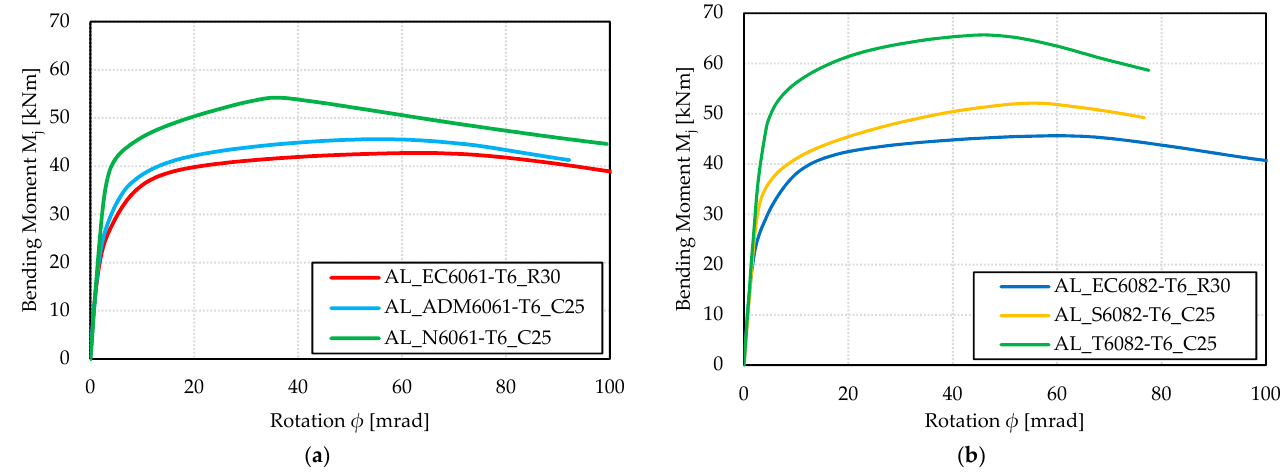
Figure 12. Moment–rotation curves for models with aluminium alloys: ( a ) EN AW-6061-T6; ( b ) EN AW-6082-T6.